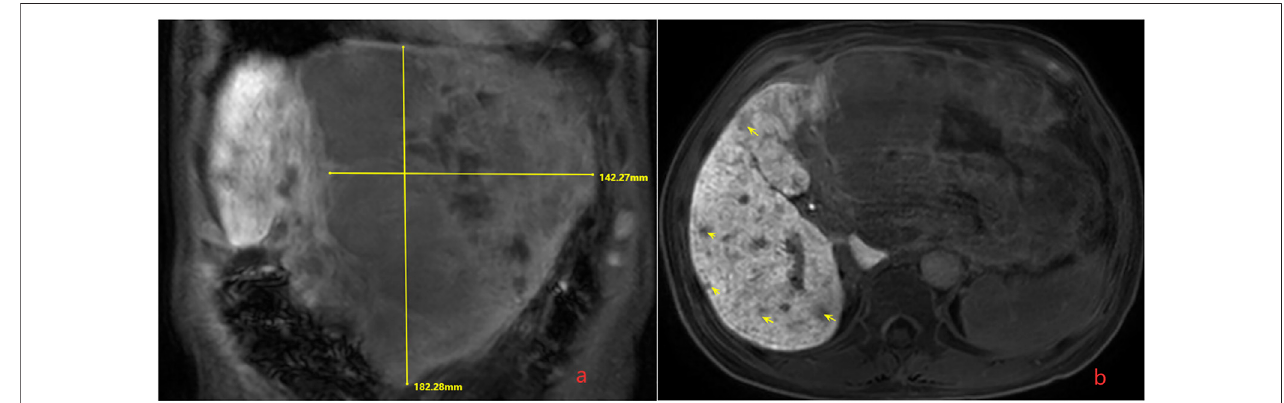
FIGURE2| Magneticresonanceimaging(MRI)showsthetumorintheleftlobeoftheliverwithmultiplemetastasesintheliver,andwithtumorthrombosisintheleft portal vein. (A) The huge tumor in the left lobe of the liver; (B) the multiple metastases in the right lobe of the liver.